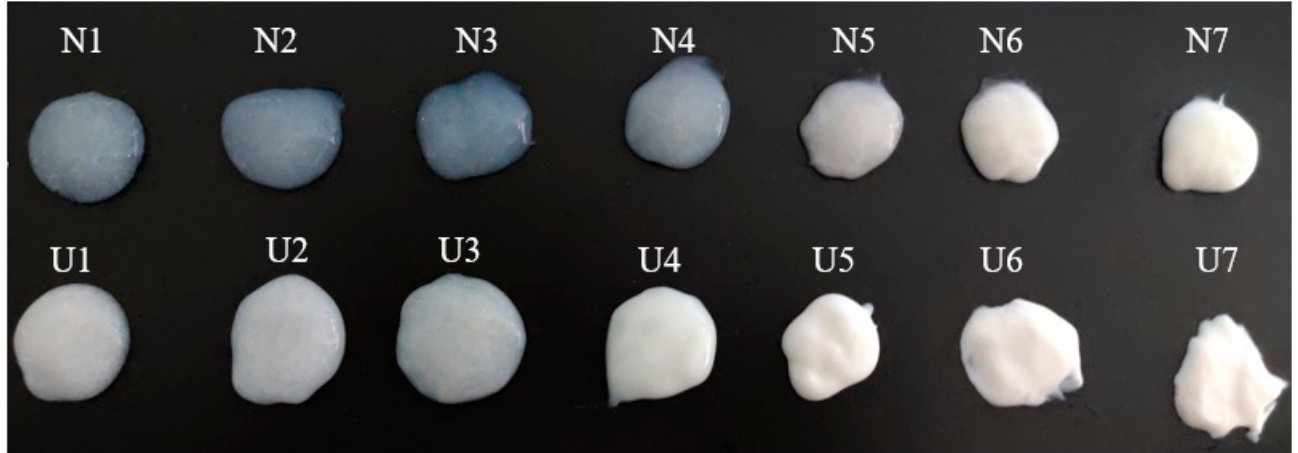
Figure 1. The profiles of emulsions (30 g·L − 1 ) with non-ultrasound and ultrasound emulsification treatment. Table 1. Changes in emulsifying activity index (EAI), emulsifying stability index (ESI), viscosity coefficients (k), flow index (n 1 and n 2 ), coefficient of determination (R 2 ) and viscosity (when the shear rate was 100 s − 1 ) of emulsion before (non-ultra- sound, N) and after ultrasound (U) emulsification treatment.